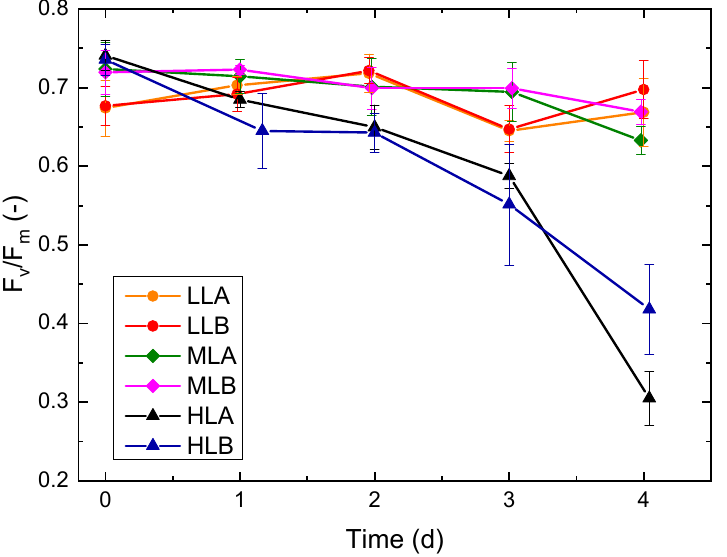
Figure 6. Trend of F v / F m (e.g., maximum quantum efficiency of PSII), over time for the six Figure 6. Trend of 𝐹 (cid:3049) /𝐹 (cid:3040) (e.g., maximum quantum efficiency of PSII), over time for the six batch batch experiments.